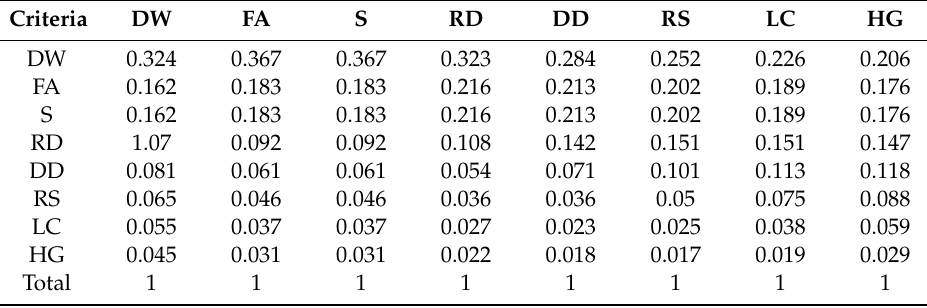
Table 6. Percentage importance values using the analytic hierarchy process (AHP).